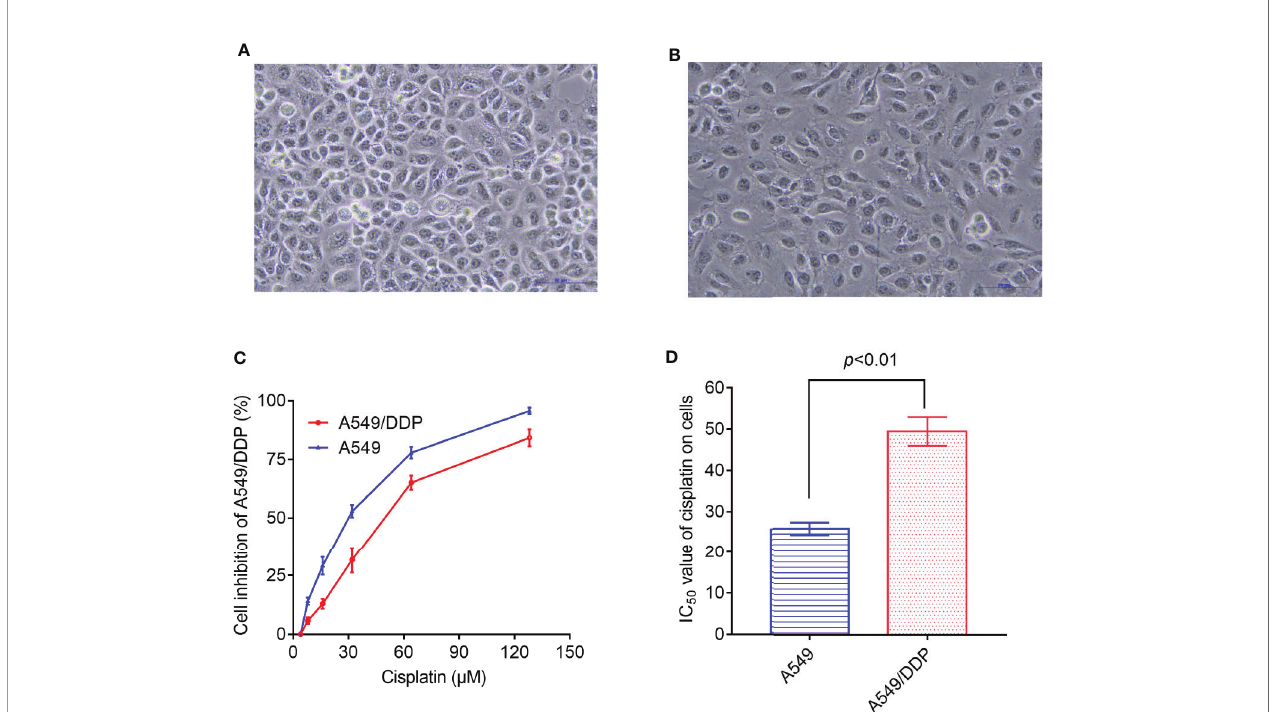
FIGURE 1 | Differences in morphology and sensitivity to cisplatin between A549 and A549/DDP. Morphological observation of A549 and A549/DDP under phase contrast microscope (A, B) . Detection of inhibition rate of cisplatin on A549 and A549/DDP (C) . IC 50 values of cisplatin in A549 and A549/DDP cells (D) . The experiments were repeated at least three times, and results were expressed as mean ±